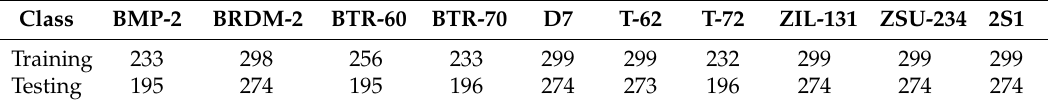
Table 3. The quantity of training and testing images.